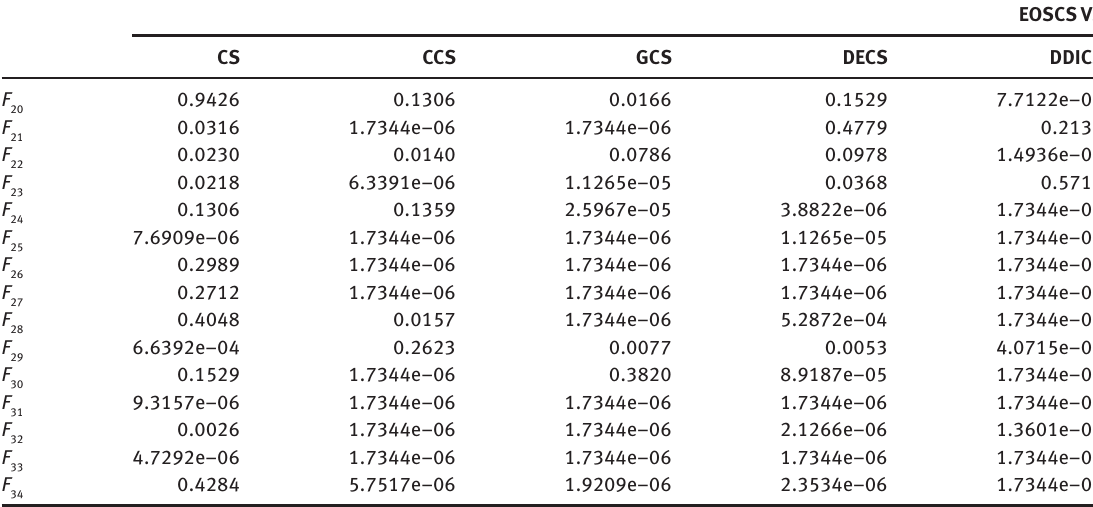
Table 13: p -Values Produced by Wilcoxon’s Test Comparing EOSCS versus CS, EOSCS versus CCS, EOSCS versus GCS, EOSCS versus DECS, and EOSCS versus DDICS Over the “Average Best-So-Far” Values from Table 7.